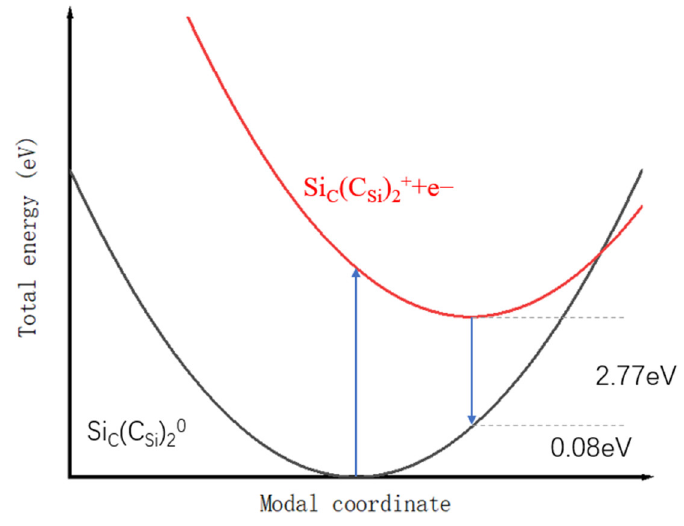
Figure 12. Configuration coordinate diagram for the Si c (C si ) 2 defect.